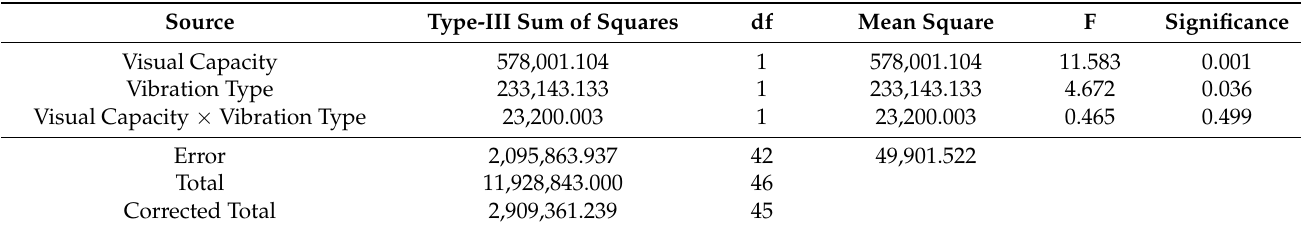
Table 4. Two-way ANOVA study of the time test as a function of the visual capacity of the subjects and the vibration type used (being df the degrees of freedom).